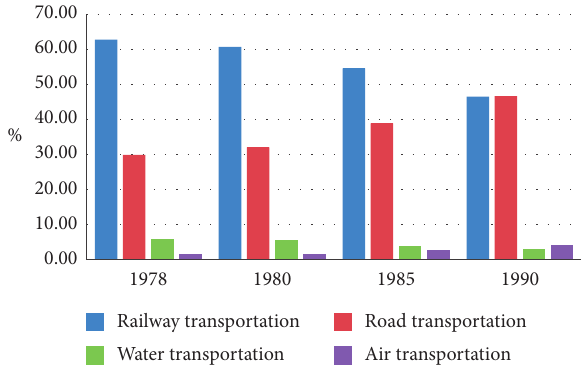
Figure 1: Passenger volume ratio for multiple transportation means during 1978–1990 in China